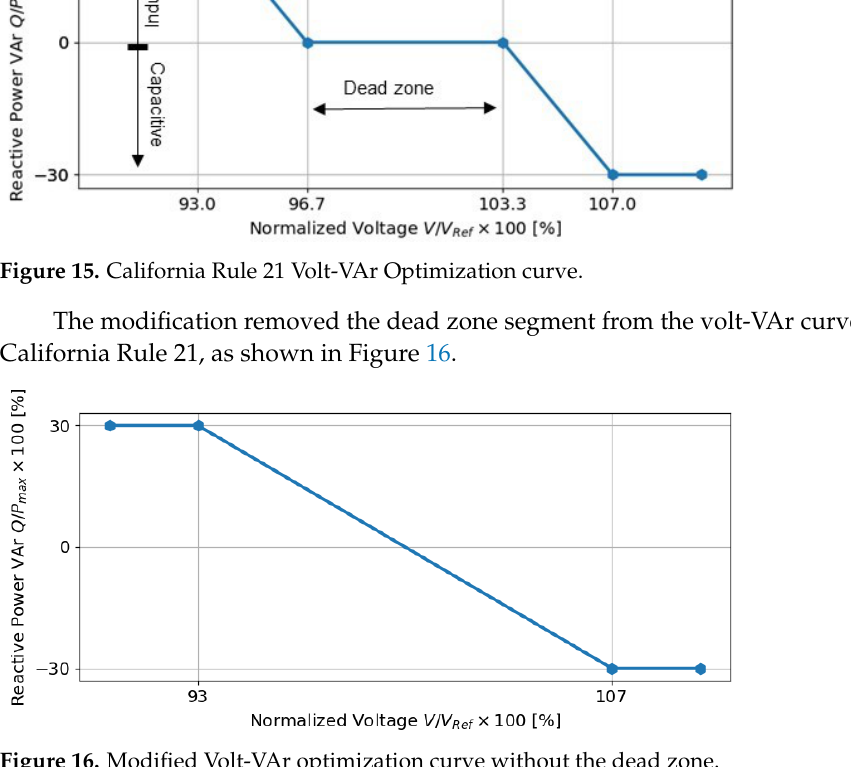
Figure 16. Modified Volt-VAr optimization curve without the dead